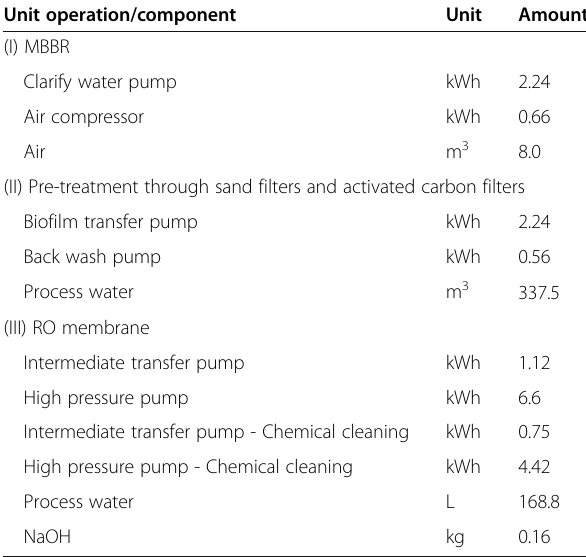
Table 3 Life cycle inventory of Combination III for integrated membrane-filtration system Unit operation/component